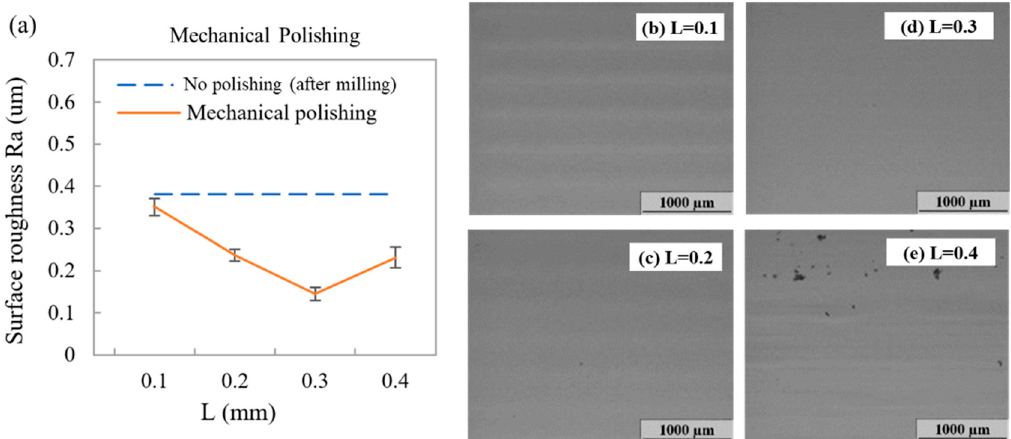
Figure 5. ( a ) Roughness of the PMMA surface after mechanical polishing at pressing lengths of 0.1, 0.2, 0.3, and 0.4 mm. Microscope images of PMMA surface within for pressing lengths of ( b ) 0.1, ( c ) 0.2, ( d ) 0.3, and ( e ) 0.4 mm. Error bars were obtained based on three measurements. For mechanical polishing using a computer numerical control (CNC) machine, the spin speed, feed rate, and overlap path were set as 8000 rpm, 1 mm / s, and 25%, respectively.